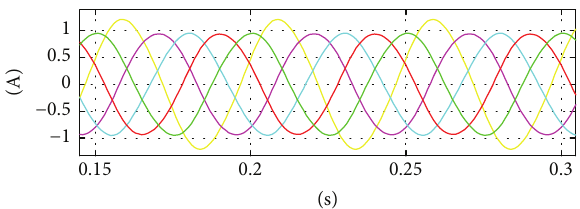
Figure 5: The phase current waveforms in fault state ( 𝑢 = 0.2 ).